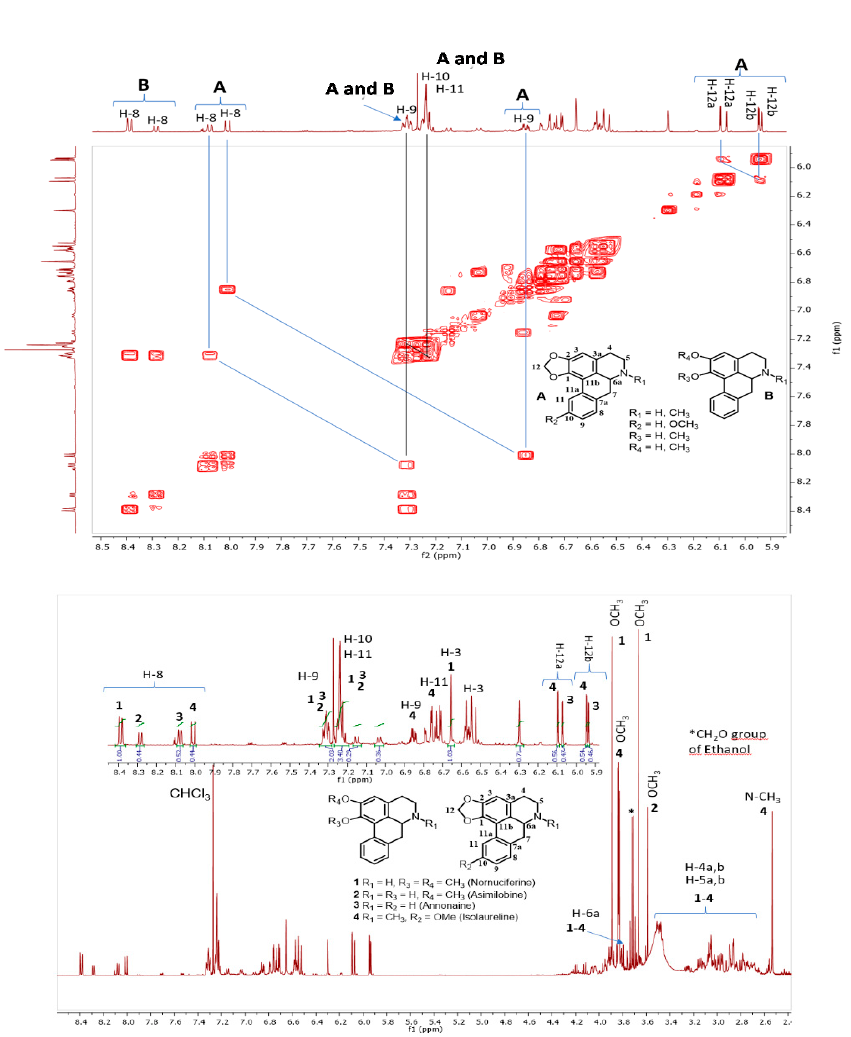
Figure 2. 1 H nuclear magnetic resonance spectrum ( bottom ) and homonuclear correlation spectroscopy (COSY) ( top ) spectrum of the alkaloid-enriched F105-150 fractions obtained from the chromatography of the selective extract of alkaloids from A . muricata peel. Cross-correlation contour peaks shown in the COSY experiment (top) allowed to establish vicinal ( 3 J ) and geminal ( 2 J ) 1 H- 1 H connectivity, which concludes that the alkaloid-enriched fraction mainly comprises two pair of aporphine alkaloids ( A , B ).